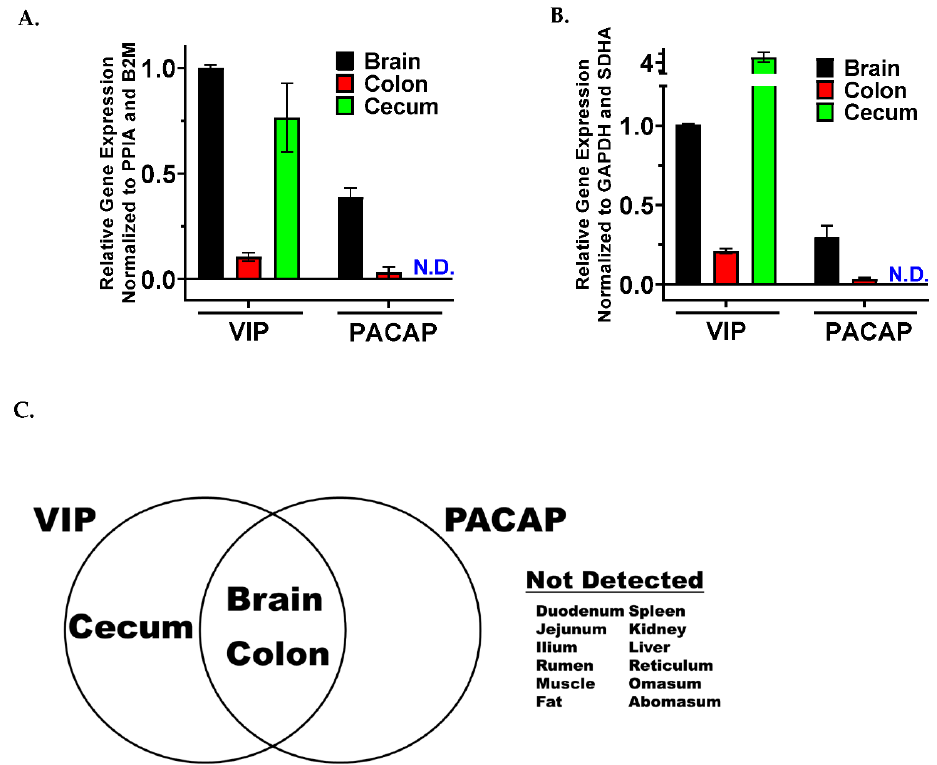
Figure 2. Similar relative mRNA profiles for VIP and PACAP ligands. Data is presented in bar graph form with technical duplicate means +/ − SD of pooled cDNA ( n = 3 − 4) for indicated tissues measured in ( A). wethers or ( B). steers. N.D. indicates no detection. ( C ). Venn diagram representing tissue expression for ligands with overlap indicating identical expression profiles between species.